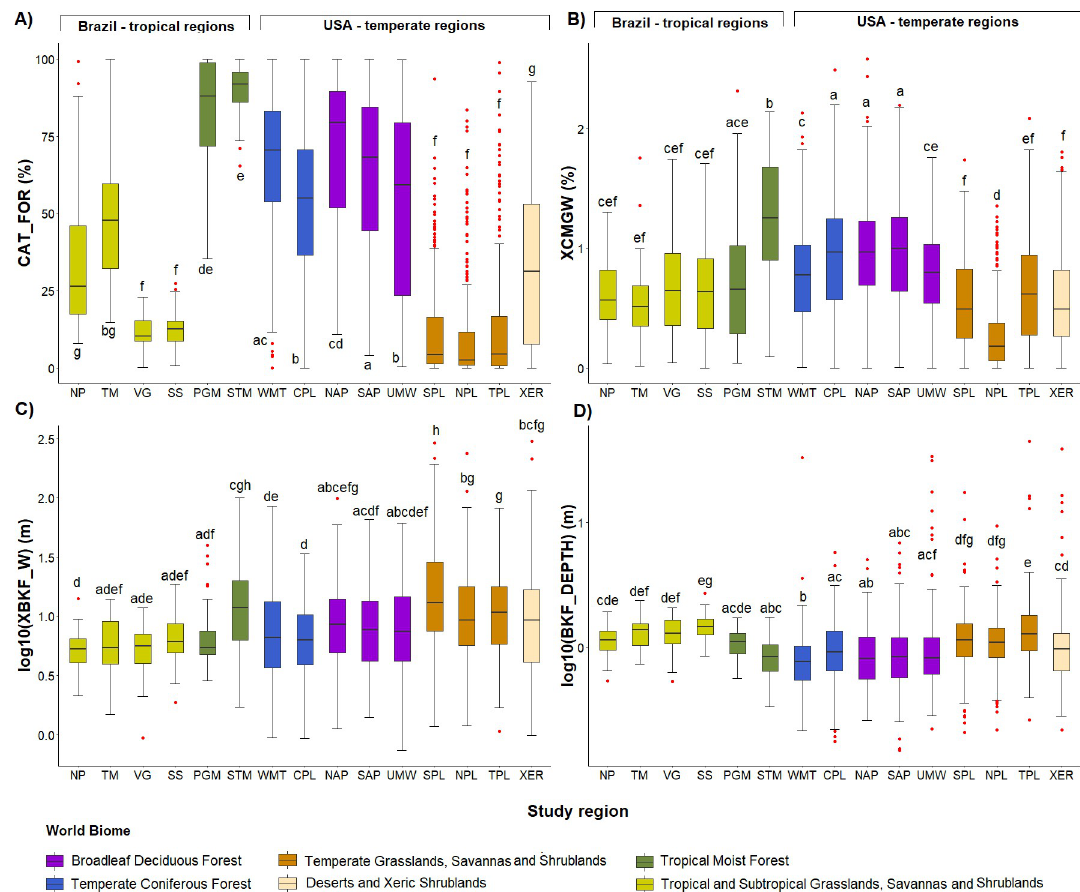
Fig 12. Boxplots of the riparian and channel characteristics for Brazilian and USA regions. (A) Catchment forest cover (CAT_FOR), (B) visual evaluation of the woody riparian forest—XCMGW, (C) log of the bankfull channel width—XBKF_W and (D) log of the bankfull channel depth—BKF_DEPTH. In the boxplots the line represents the median, the box is the first (25%) and the third (75%) quartiles, the whiskers extend to the most extreme data point which is no more than 1.5 times the length of the box away from the box, the red dots are the outliers defined by the ‘1.5 rule’. The colours in the boxes indicate the biome where each region is located. Different letters next to whiskers indicate significant difference in post–hoc comparisons.